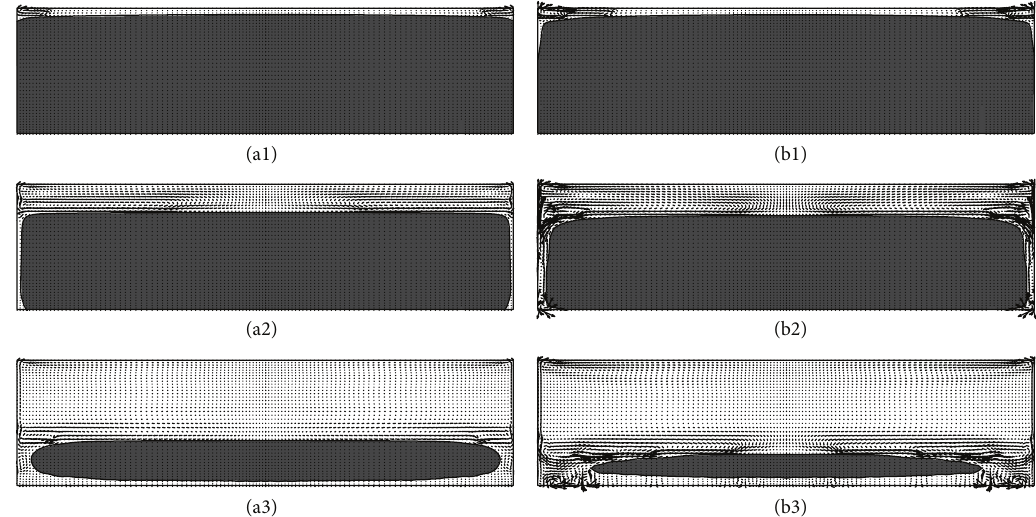
Figure 3: Melting sequences of silicon feedstock for DS processes with different crucible thermal conductivities: (a1)–(a3) 2 W/m ⋅ K; (b1)–(b3) 6 W/m ⋅ K. (a1) and (b1): 500 min; (a2) and (b2): 560 min; (a3) and (b3): 700 min.